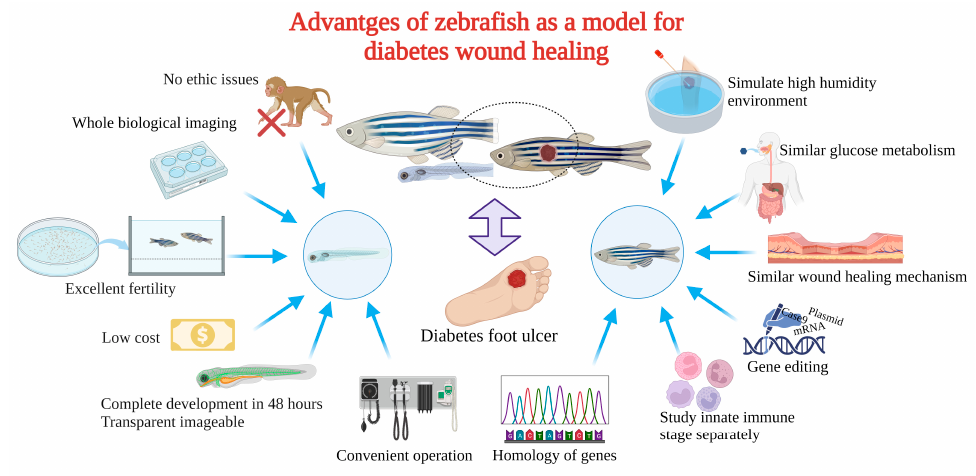
Figure 3. Advantages of zebrafish for diabetes mellitus with wound model.